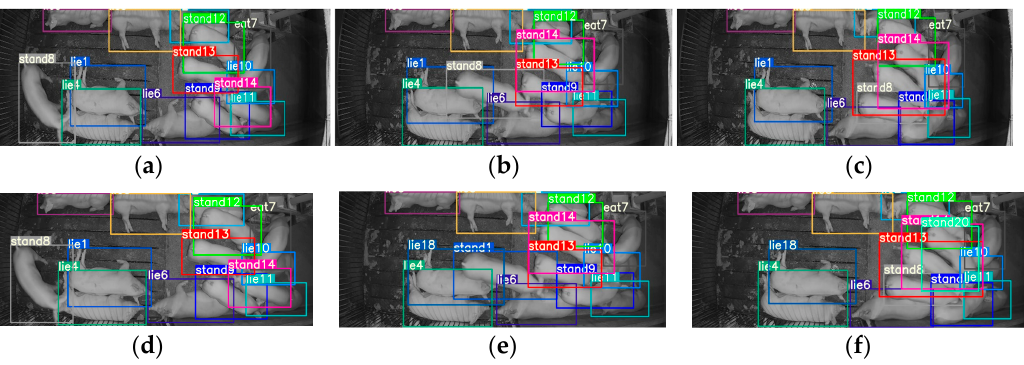
Figure 12. Tracking results of Pig 10 using improved and original DeepSORT based on YOLO v5s DeepSORT model for night condition. ( a – c ) show the results of improved DeepSORT, and ( d – f ) show the results of original DeepSORT. ( a ) Improved model, frame 50; ( b ) Improved model, frame 100; ( c ) Improved model, frame 150; ( d ) Frame 50, Pig10; ( e ) Frame 100, Pig10; and ( f ) Frame 150, Pig10.